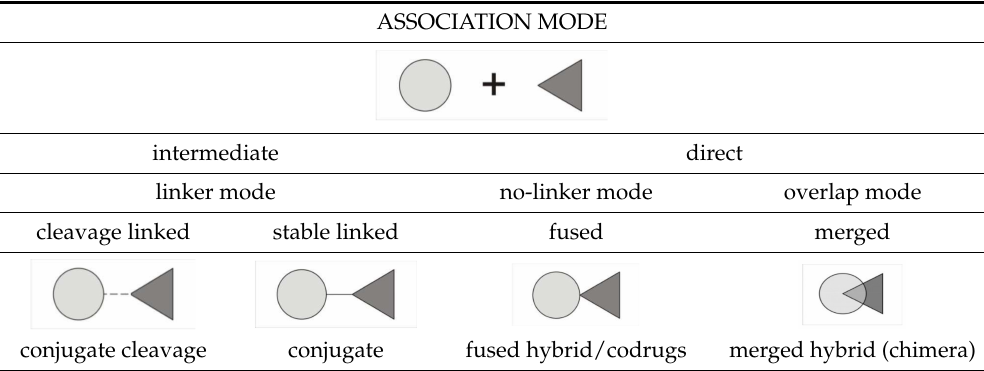
Table 1. The most common types of hybridized compounds.